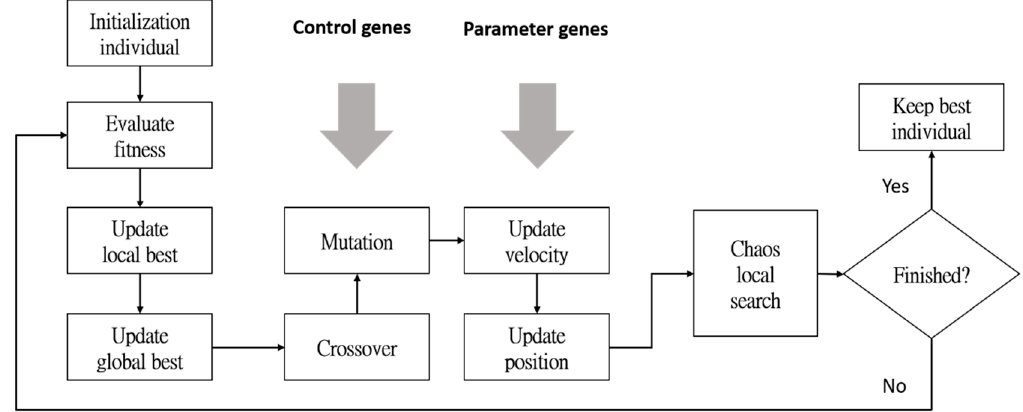
Figure 9. Flowchart of the proposed improved particle swarm optimization (IPSO) algorithm.